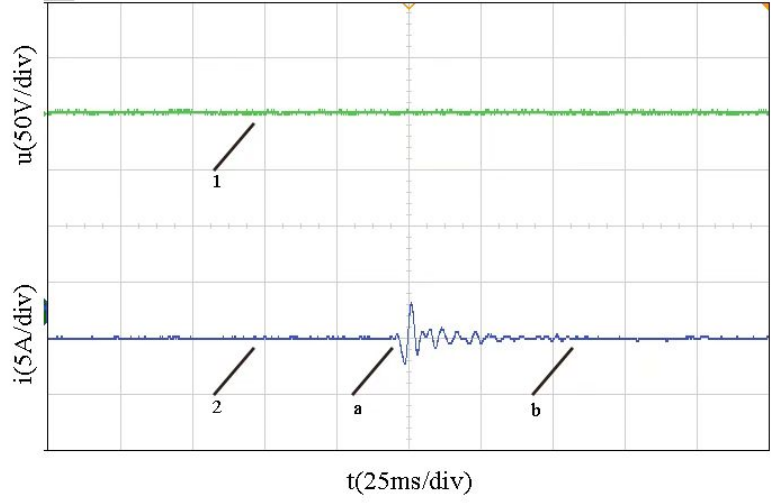
Figure 10. Experimental waveform with continuous load fluctuation. Figure 11 is a line diagram of the converter efficiency at different input voltages. Set